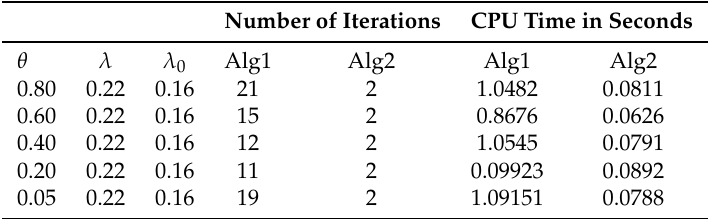
Table 2. Example 1: Algorithm 1’s numerical comparison with Algorithm 1 in [19].